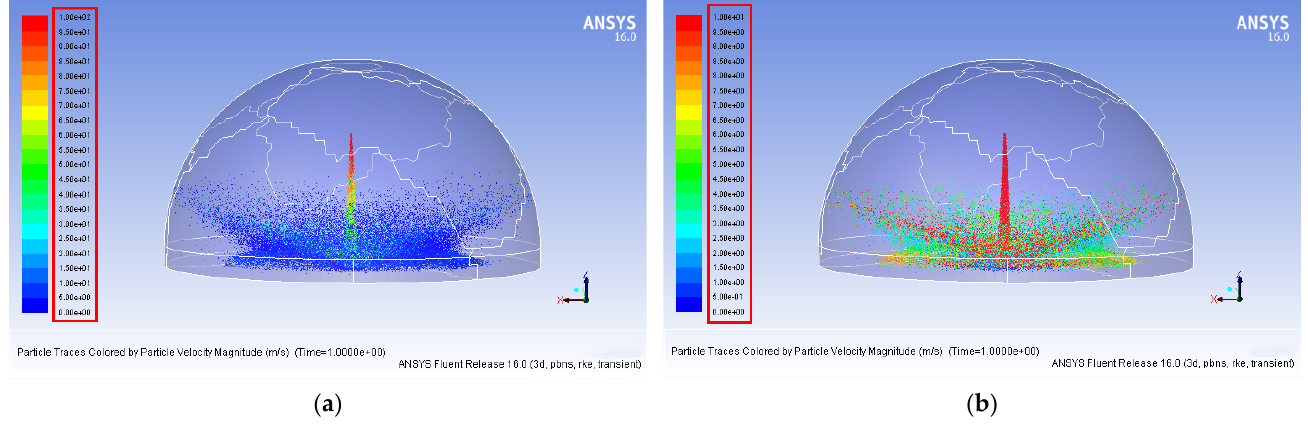
Figure 14. Display of the distribution of the velocity of paint mist particles within 0–0.03 s of the retention time: ( a ) display range 0–100 m/s; ( b ) display range 0–10